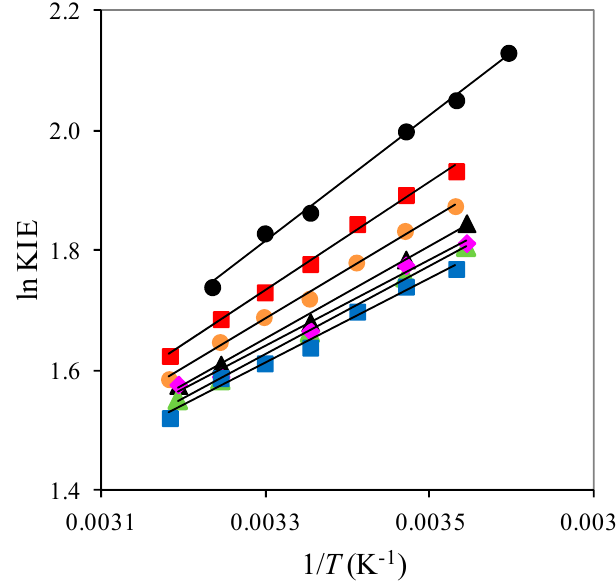
Figure 3. Temperature dependence of KIE in the reaction of ascorbate with hexacyanoferrate(III) ion in presence of different concentrations of quaternary ammonium salts in water. Key: green triangle, 0.005 M TMACl; black triangle, 0.005 M TPACl; magenta diamond, 0.005 M TBACl; blue square, 0.01 M TEACl; orange circle, 0.006 M PQCl 2 ; red square, 0.1 M AChCl; black circle, 0.1 M BTMACl. Abbreviations as noted in Table 1.